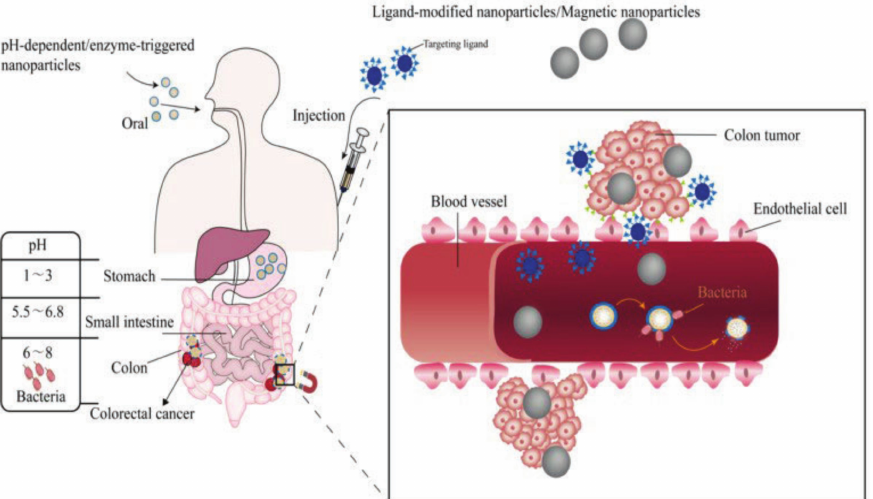
Figure 5. Administration routes for polymeric nanoparticles in the treatment of colorectal cancer. Reprinted with permission from Ref. [41]. Copyright 2022